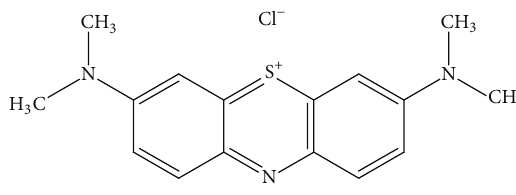
Figure 1: Structure of methylene